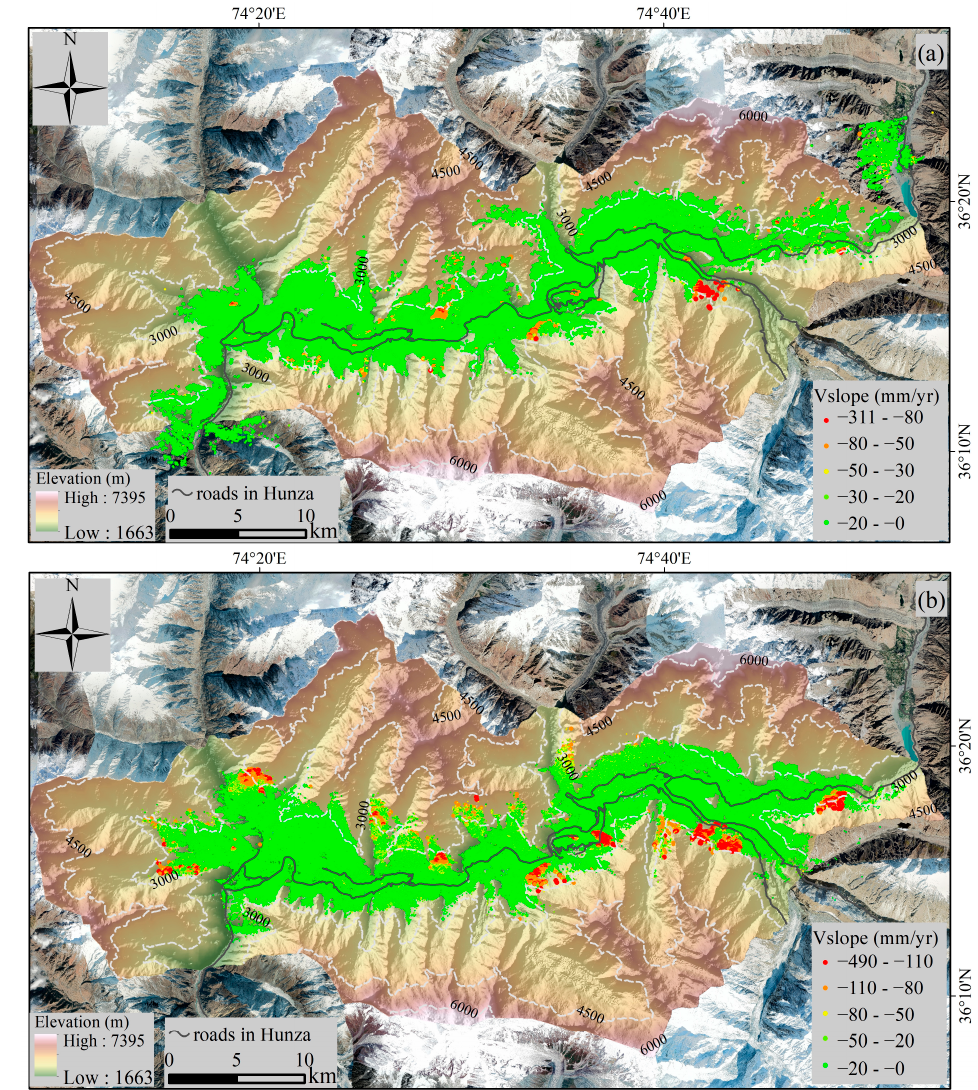
Figure 6. Displacement velocity along slope and landslides detected by SBAS-InSAR applying the ascending (Path 27, Frame 117, in ( a )) and descending orbit data (Path 107, Frame 473, in ( b )) Sentinel-1A dataset. The black line represents the roads in the Hunza Valley.